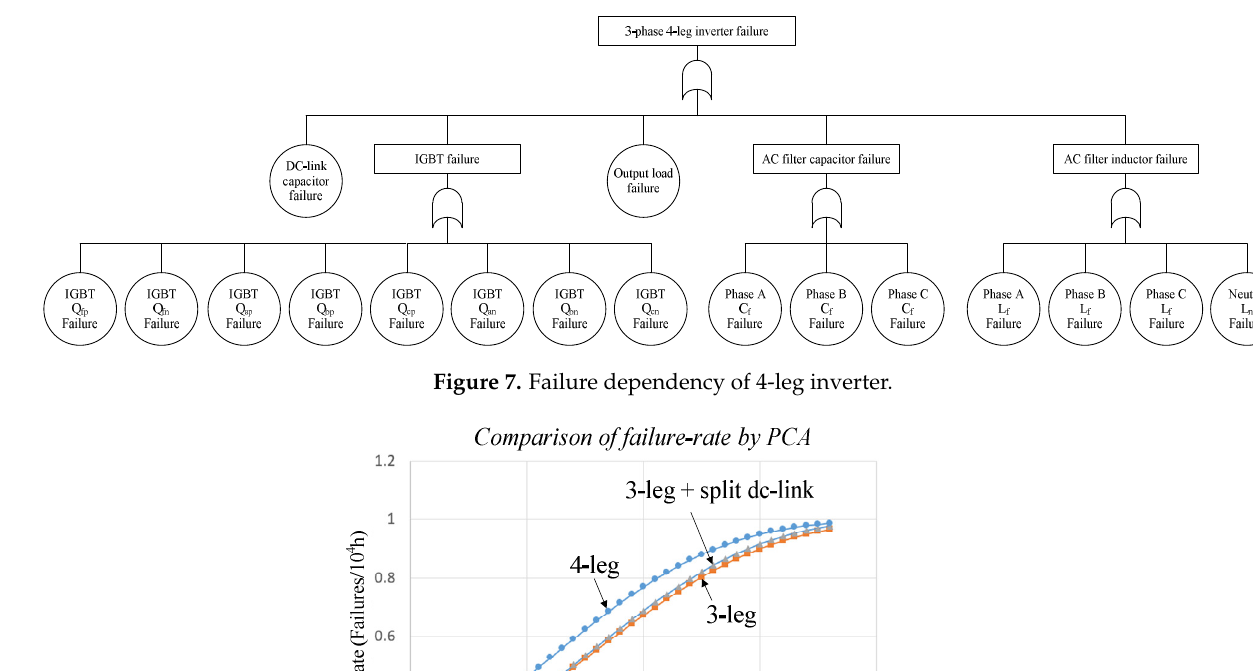
Figure 6. Failure dependency of three-phase 3-leg inverter with split DC-link capacitors.